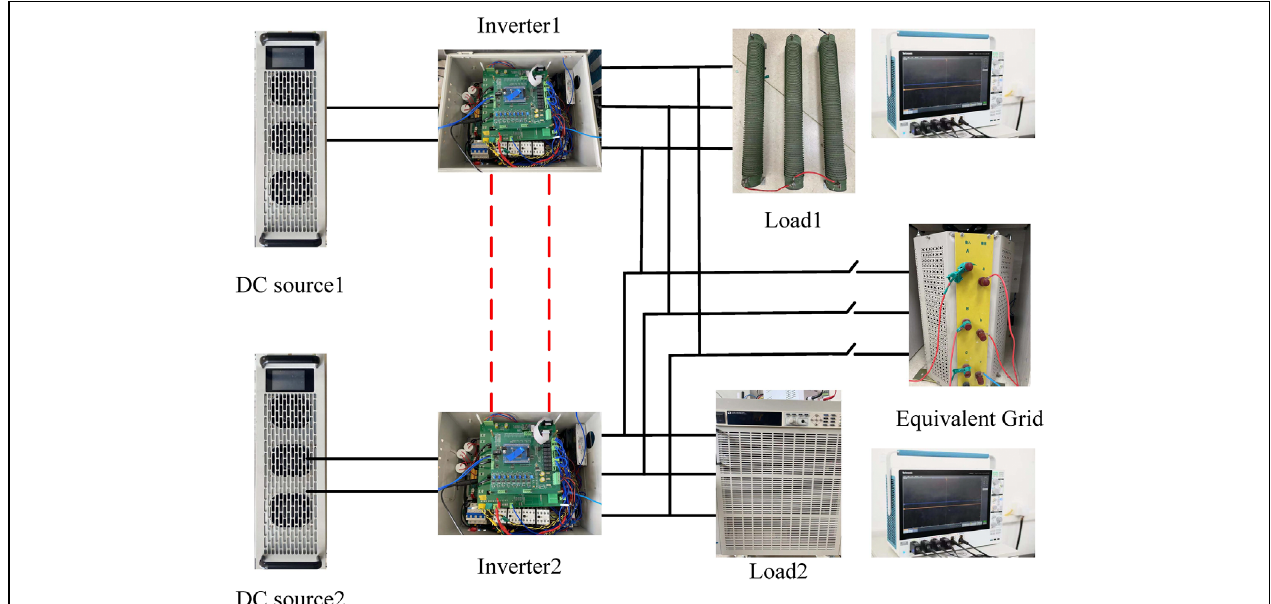
FIGURE 10 | Experimental